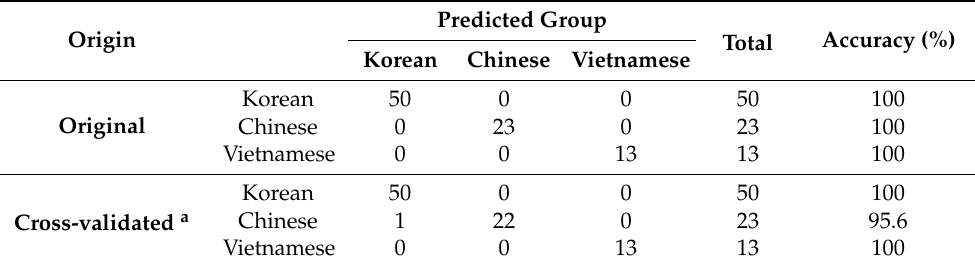
Table 3. Reclassification results for the origins of red pepper powder samples using the canonical discriminant